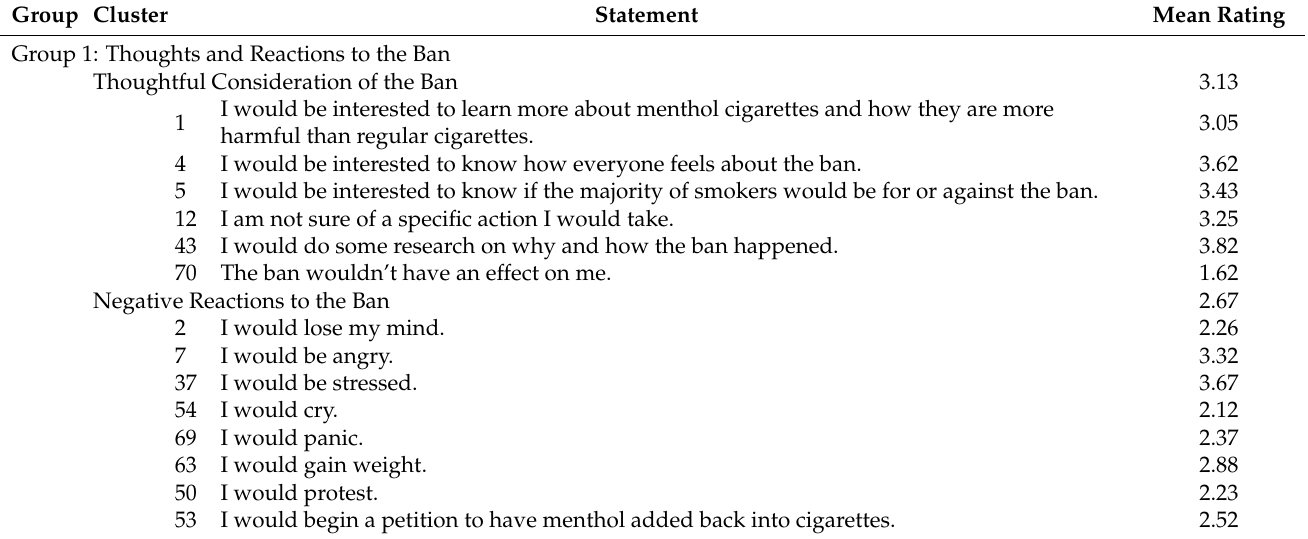
Table 2. SGM menthol cigarette smoker-identified clusters and statements describing reactions to a hypothetical ban on menthol in